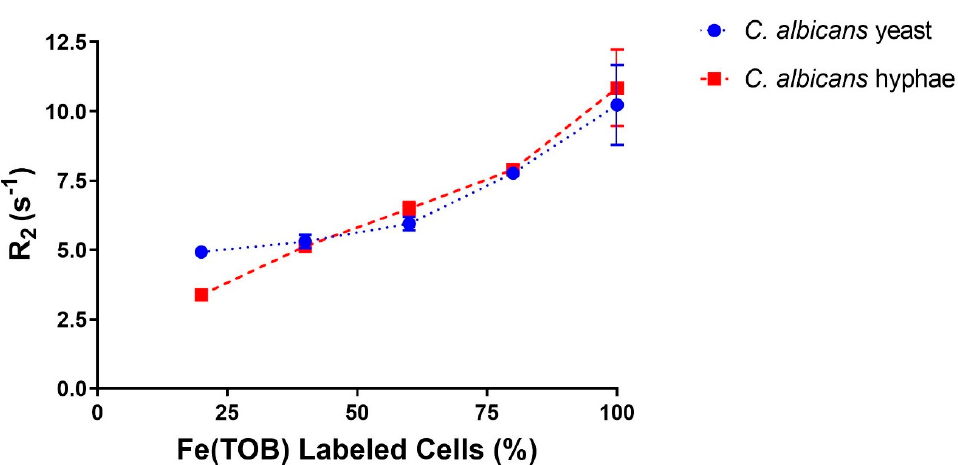
Figure 6. R 2 values of water protons determined using a CPMG sequence on samples containing increasing concentrations of Fe(TOB)-labeled cells suspended in 15% ( w / v ) gelatin in a 9.4 T NMR spectrometer.